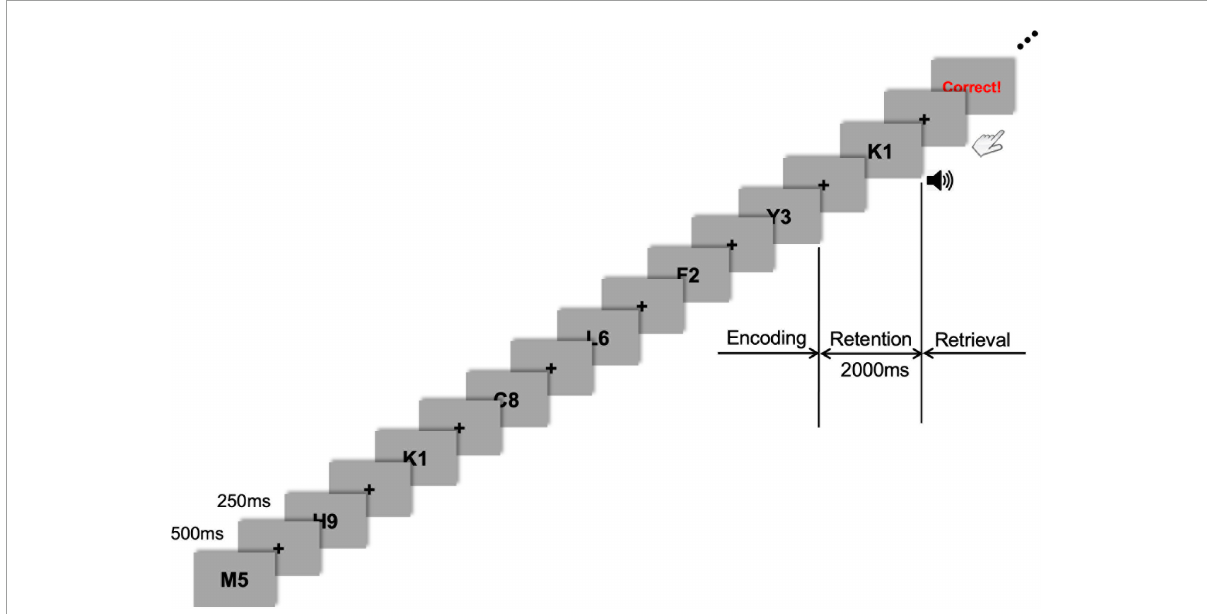
FIGURE1 Task flow of the sample stimuli. Stimulus presentation was followed by a fixation cross presented during every inter-stimulus interval (ISI). During the encoding phase, seven letter-numeral combinations were visually presented consecutively on the display monitor for 500 ms with an ISI of 250 ms. After this encoding phase, a 2-s retention period of working memory was given before the retrieval (probe-test) phase that was cued by a 1-s auditory beep. Visual feedback (either “Correct!” or “Incorrect!” or “No Response”) was promptly shown on the monitor after each response depending on whether the probe item was part of the memory set presented during the encoding